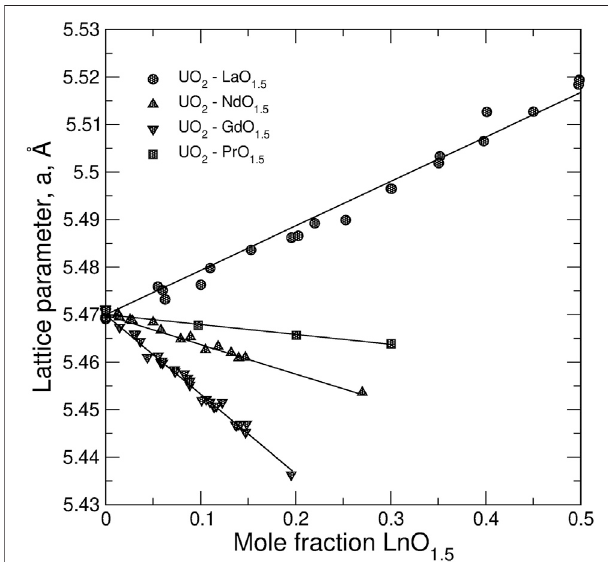
FIGURE 5 | The dependence of the lattice parameter in stoichiometric UO 2 – Ln O 1.5 systems on the composition. The data are fi tted to linear equationstodeterminetheradiiofU 4 , 8 , Ln 3 , 8 ,andU 5 , 8 ,.Theexperimentaldata are from (La) Hill (Hill, 1962), Stadlbauer et al. (Stadlbauer et al., 1974), Preiur et al. (Prieur et al., 2018); (Pr) Yamashita et al. (Yamashita et al., 1985); (Nd) Une and Oguma (Une and Oguma, 1983a), Ohmichi et al. (Ohmichi et al., 1981), Fukushima et al. (Fukushima et al., 1983); (Gd) Baena et al. (Baena et al., 2015), Ohmichi et al. (Ohmichi et al., 1981), Cardinaels et al. (Cardinaels et al., 2012), Leyva et al. (Leyva et al., 2002), Fukushima et al. (Fukushima et al., 1982), Hirai and Ishimoto (Hirai and Ishimoto, 1991), Soldati et al. (Soldati et al., 2016).